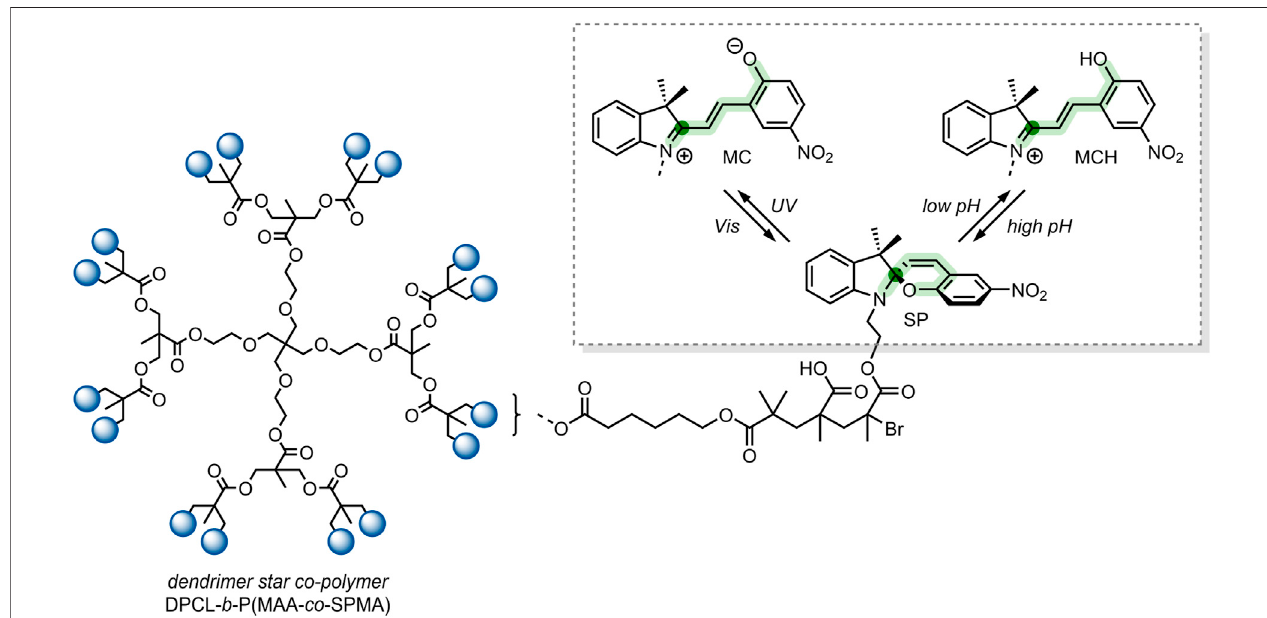
FIGURE 8 | The structure of the DPCL- b -P(MAA- co -SPMA) complex, which self-assembles into micelles in an aqueous solution. Framed : UV light irradiation and lowpH-inducedisomerisationoftheSPswitchintotheMCandMCHform,respectively(Yuanetal.,2018).Thespiro-carbonishighlighteddark-green,andtheSPchain is highlighted